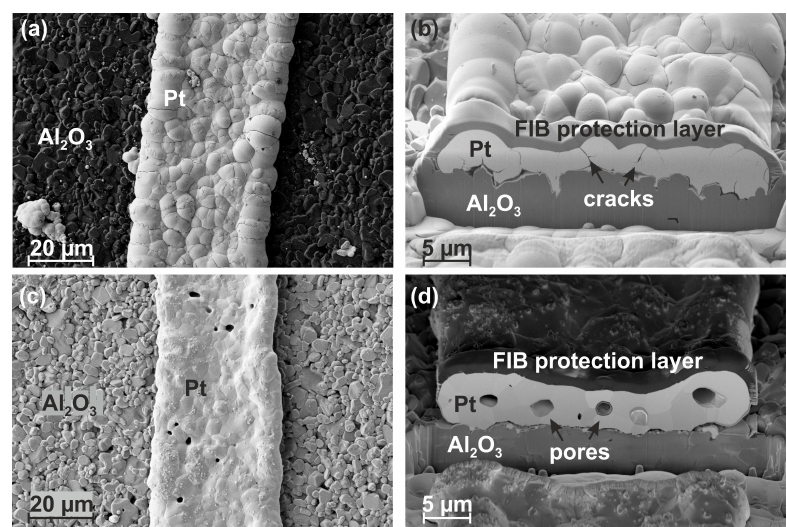
Figure 6. Surface and cross-section images (3 kV, SE2) of electroless-deposited antenna structures: ( a ) and ( b ) in the as-prepared state, ( c ) and ( d ) after annealing for 2 h at 1000 ◦ C in